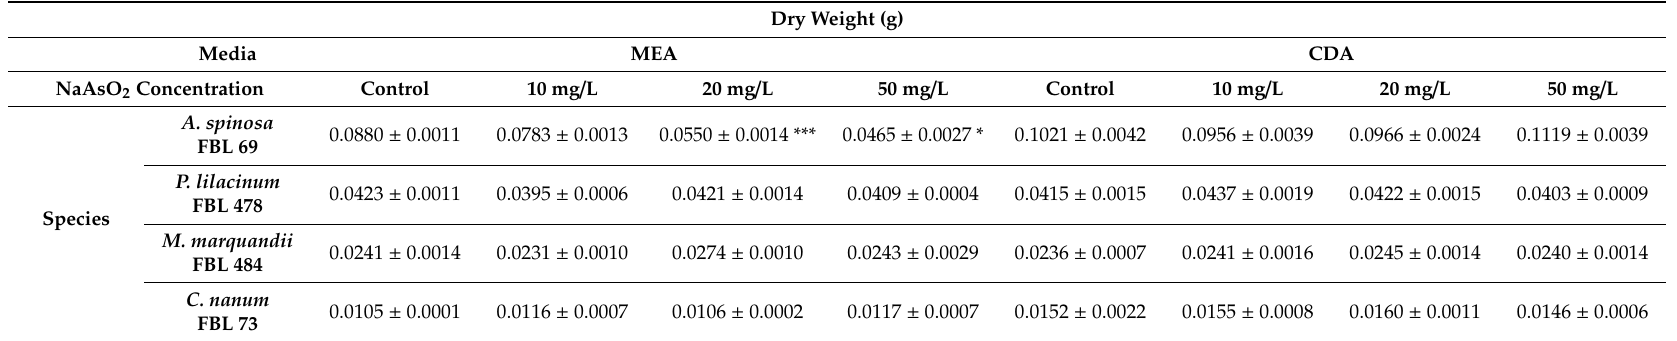
Table 2. Dry weight values of fungal biomass after seven days of growth at 25 ◦ C. Data are expressed as the mean ± standard error of independent biological replicates a